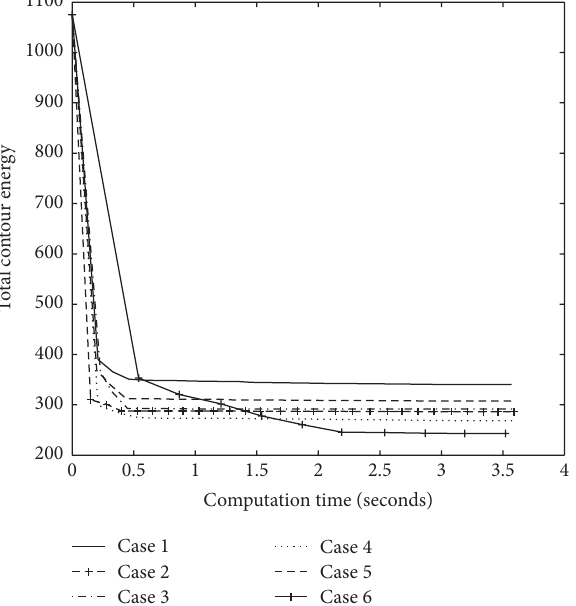
Figure 7: Contour energy versus computation time plot for “mul- tipopulation PSO” method with six different cases of inertia in case of “Peppers” image.